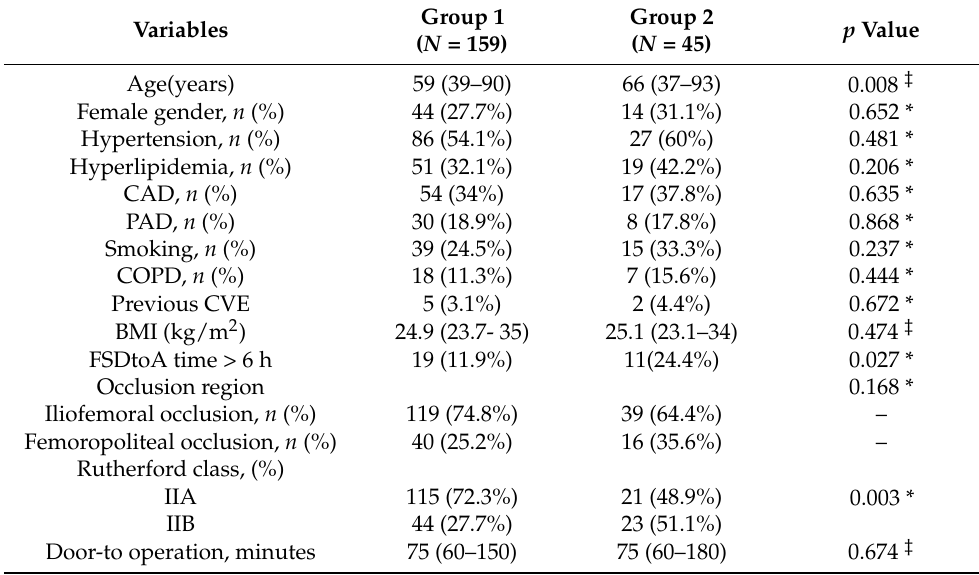
Table 1. Demographic data of the